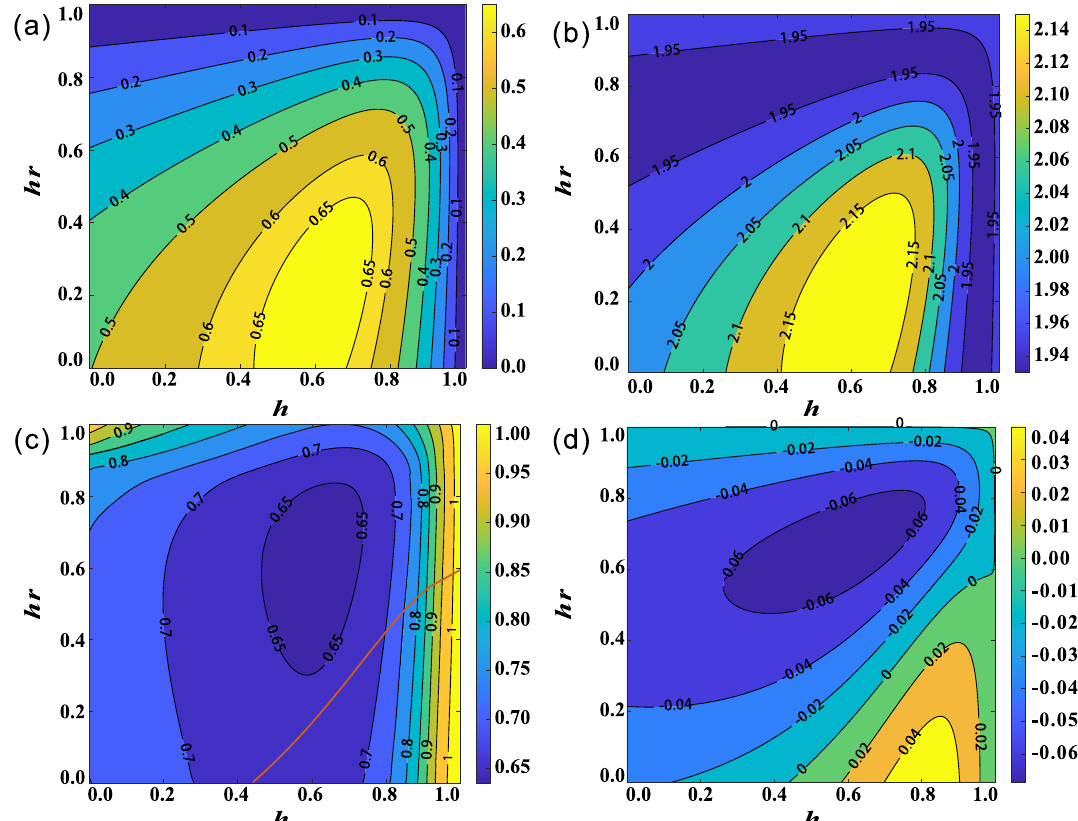
Figure 6. (Color online) Revival effects of nonlocal quantum correlations in completely correlated SGAD 1 ). ( a ) The contour plot of concurence C . ( b ) The contour plot of Bell parameter B . ( c ) The channel ( µ = contour plot of critical radius R AB . ( d ) The contour plot of relative purity (cid:31) P strength of WM and QMR,